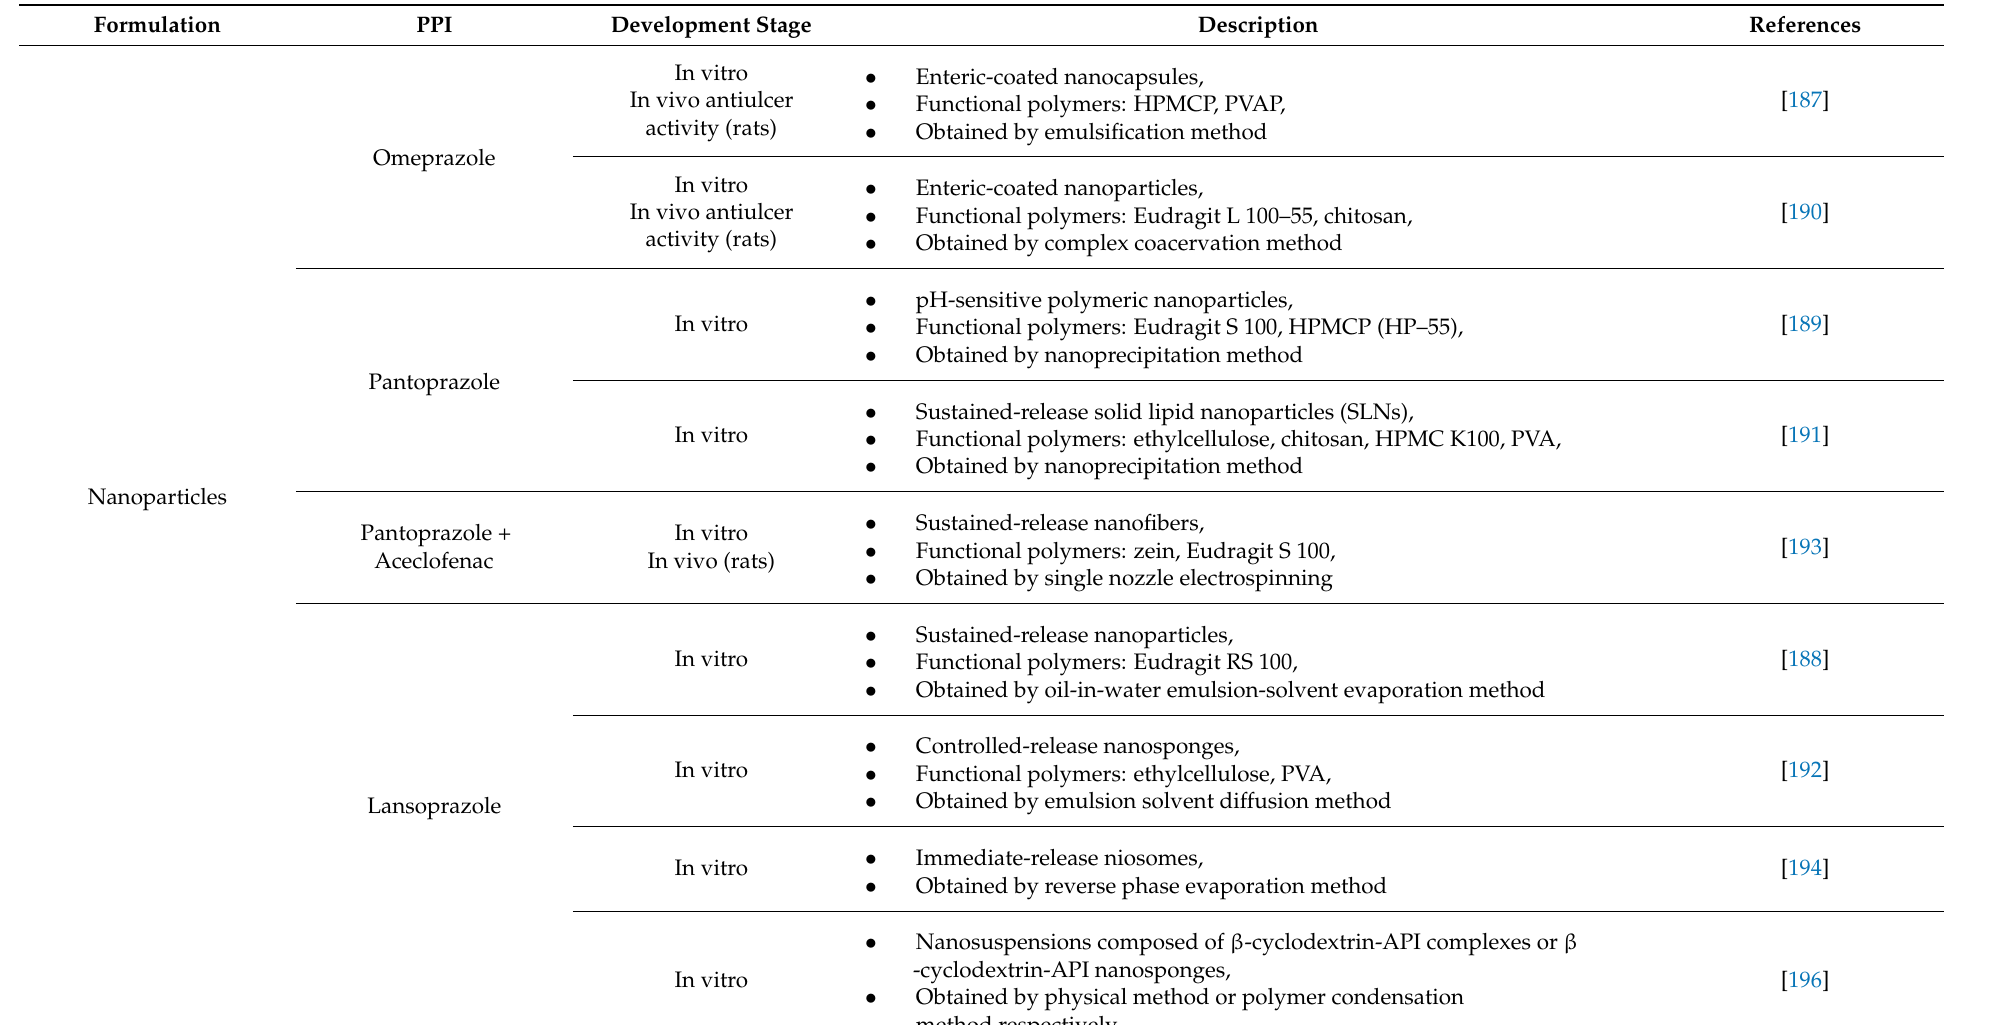
Table 5. PPIs’ formulations described in the